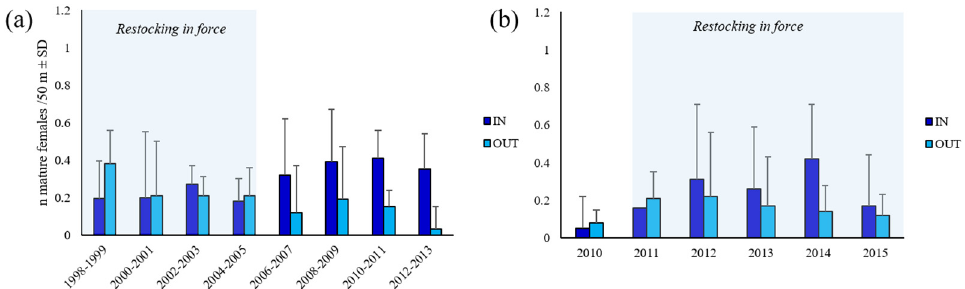
Figure 7. Plot showing ( a ) biannual mature female CPUE ( n . females/50 m ± s.e.) trends inside and outside Su Pallosu and ( b ) annual mature female CPUE ( n . females/50 m ± s.e.) trends inside and outside Buggerru. Pale blue rectangles indicate the restocking period.